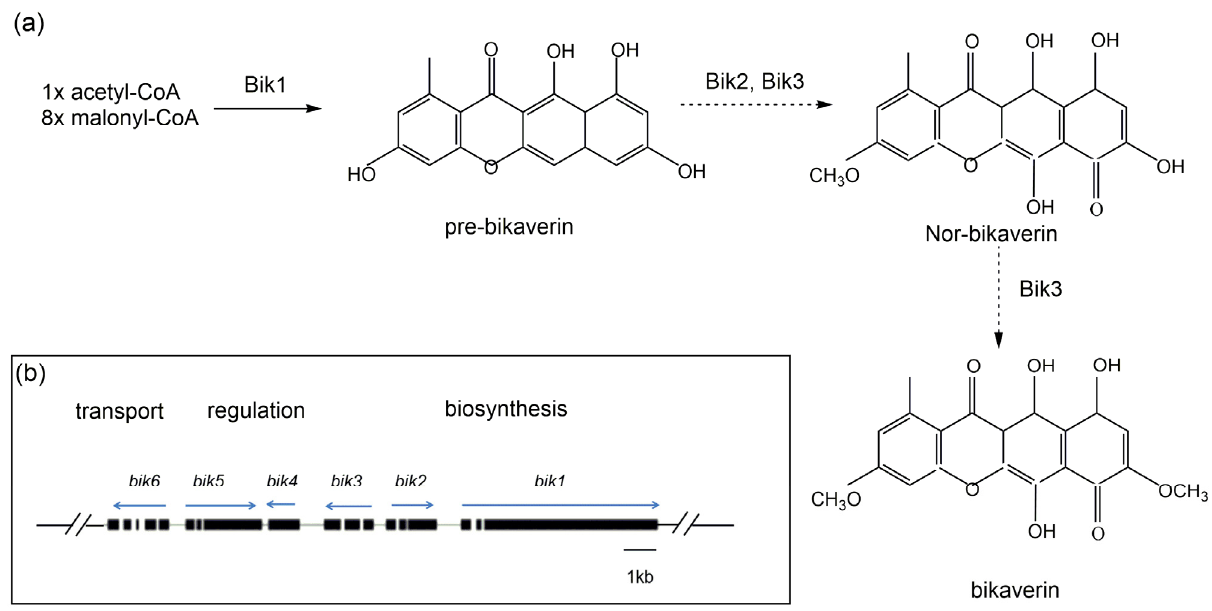
Figure 3. Schematic representation of bikaverin biosynthetic route in Fusarium fujikuroi . ( a ) The preferred biosynthetic steps are indicated by bold arrows, and some possible conversions are indicated by dashed arrows. ( b ) Organization of bikaverin (bik) gene cluster in F. fujikuroi . Direction of transcription for each predicted gene is indicted by the arrows [62,63].